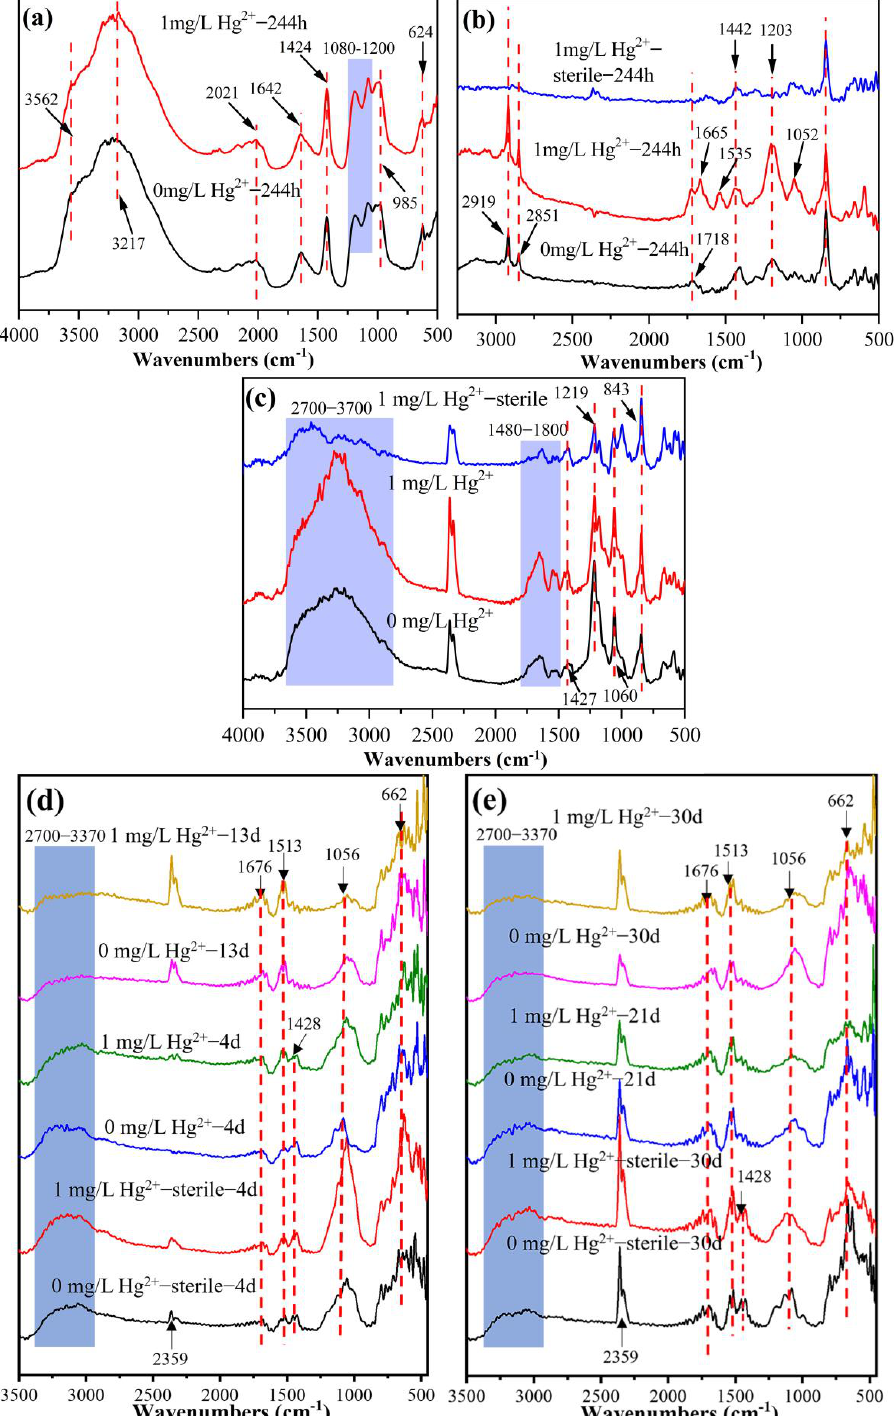
Figure 6. FTIR images of bacterial cells of A. ferrooxidans ATCC 23270 in the presence of Hg 2+ . ( a ) Fe 2+ oxidation; ( b ) S 0 oxidation; ( c ) anaerobic Fe 3+ reduction coupled with S 0 oxidation; ( d ) the aerobic stage of aerobic–anaerobic coupling; ( e ) the anaerobic stage of aerobic–anaerobic